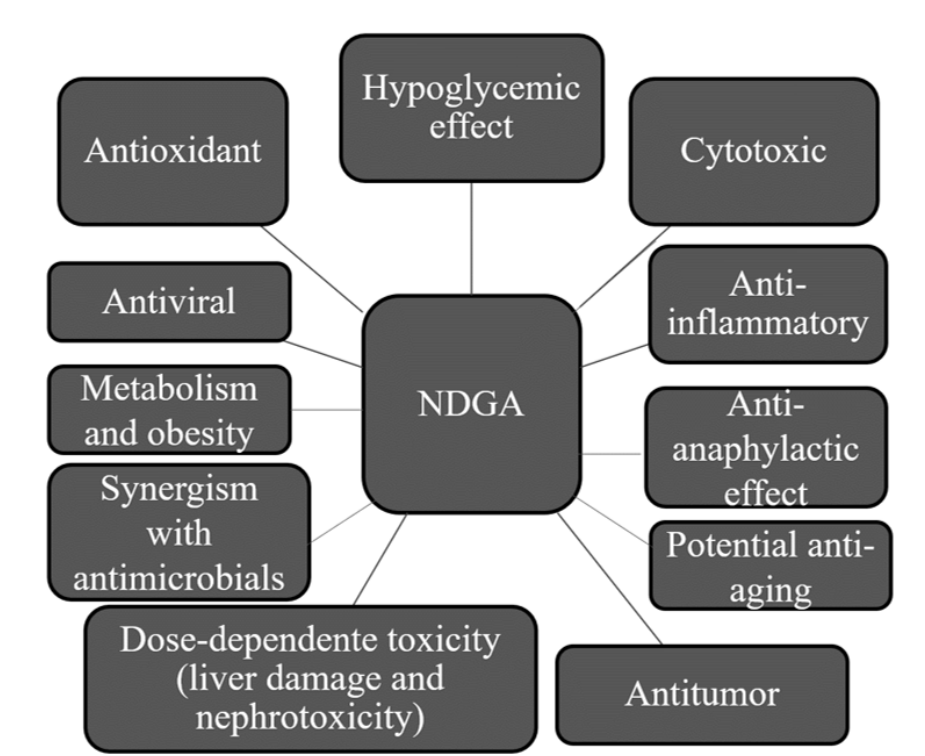
FIGURE 2 - Effects and biological activities of